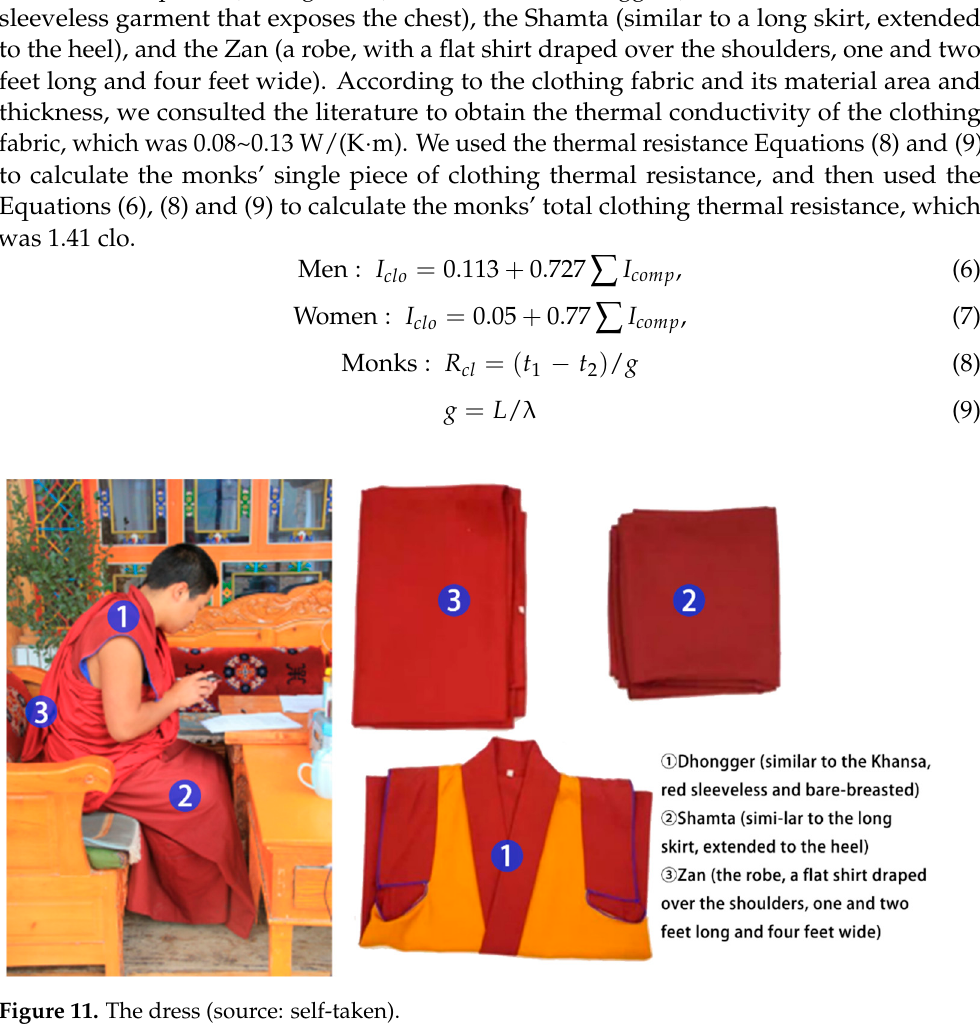
11 of 21 Figure 10. Frequency of the distribution of indoor operating temperature (source: self-drawn). 3.2. Garment Thermal Resistance and Metabolic Rate During the questionnaire survey, the subjects were sat in a sitting position, and very few of them were stood, while the clothing of the subjects was recorded, referring to the Indoor Thermal and Humid Environment Evaluation Standard for Civil Buildings (GB/T 50785-2012) [58]. The thermal resistance of the wooden seats was corrected according to the ASHRAE Standard 55-2004, and the thermal resistance of a single piece of clothing was expressed in clo (1 clo = 0.155 m 2 ·K/W), using Equations (6) and (7) to calculate the total thermal resistance of garments for different age groups of interviewees. Their daily dress includes three pieces (see Figure 11), which are the Dhongger (similar to the Khansa, a red sleeveless garment that exposes the chest), the Shamta (similar to a long skirt, ex- tended to the heel), and the Zan (a robe, with a flat shirt draped over the shoulders, one and two feet long and four feet wide). According to the clothing fabric and its material